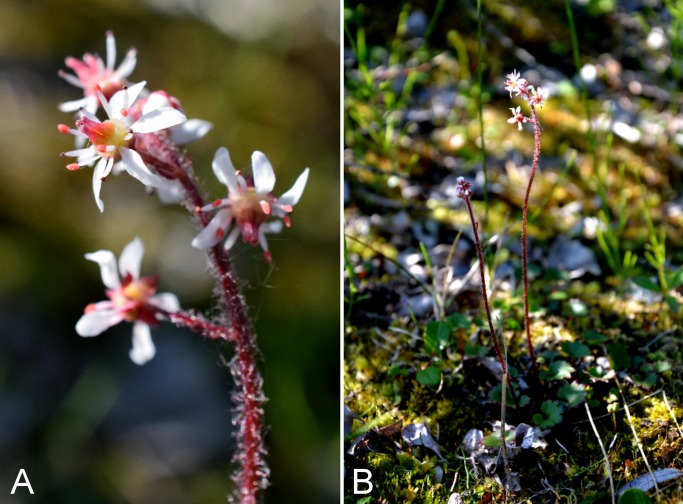
Micranthes porsildiana.(A) Inflorescences, Saarela et al. 4251. (B) habit, Saarela et al. 4251. Photographs by P. C. Sokoloff.